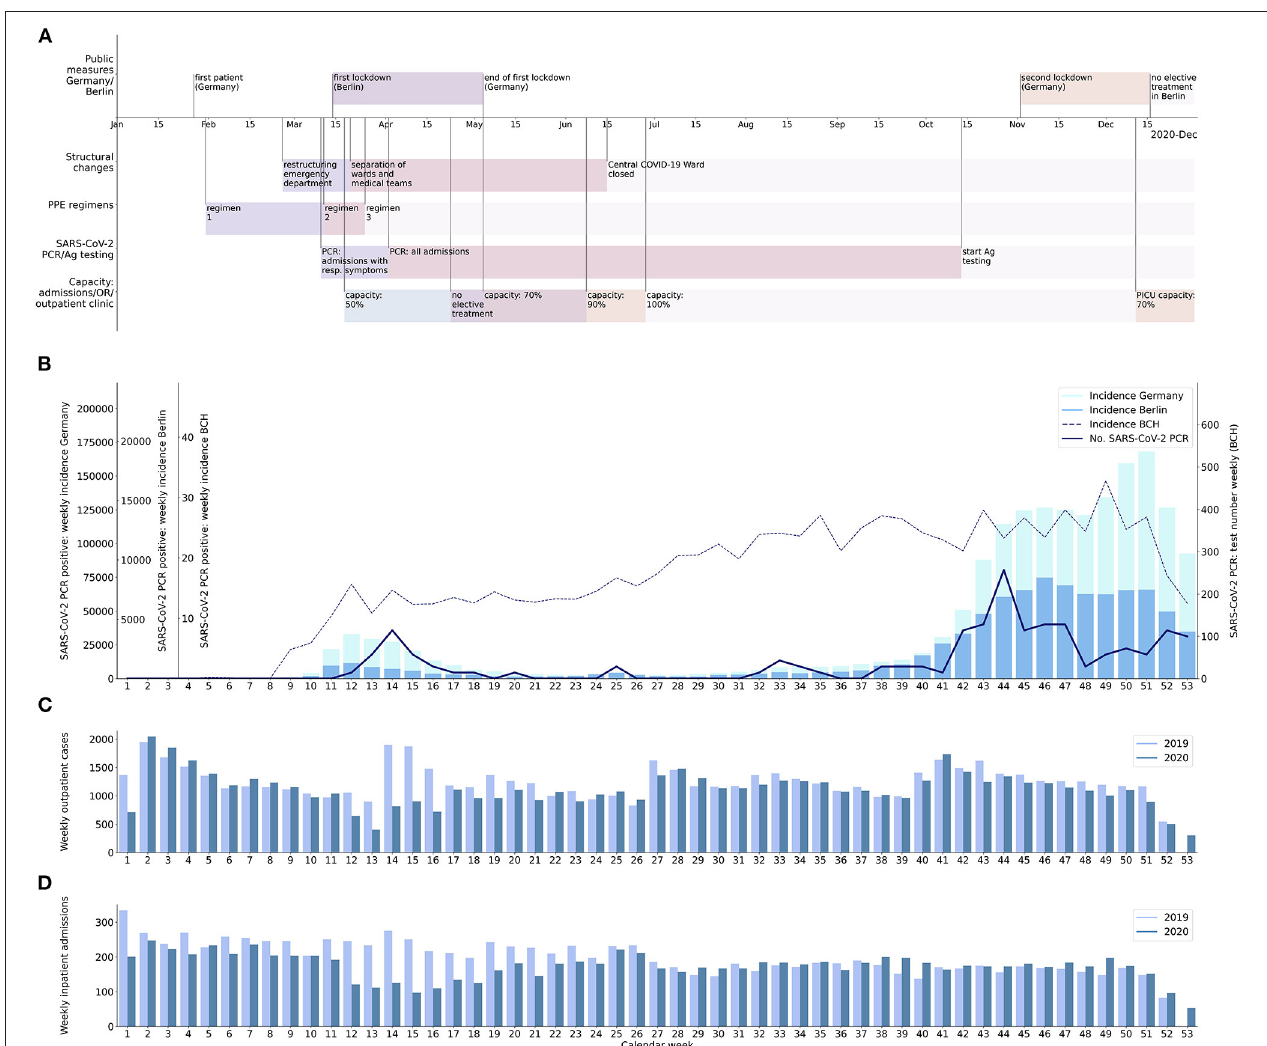
FIGURE 1 | Procedural changes at BCH in relation to changes in incidence of SARS-CoV-2 infection and inpatient and outpatient case numbers. (A) Timeline with an overview on internal and external measures imposed as a response to the COVID-19 pandemic; first row: events and public measures in Germany or Berlin; second row: reorganization of wards and staff; third row: personal protective equipment (PPE) regimens (for description of regimens, see Table 1 ); fourth row: SARS-CoV-2 PCR and SARS-CoV-2 Ag testing strategies; fifth row: limitation of inpatient treatment, outpatient treatment and operation room (OR) capacities; PICU: pediatric intensive care unit. (B) Incidence of SARS-CoV-2 infection per calendar week in Germany (bright bars), Berlin (dark bars), and at BCH (thick line), and number of SARS-CoV-2 PCR tests undertaken on inpatients or patients to be admitted per calendar week (dashed line). (C) Number of outpatient cases at BCH per calendar week in 2019 (bright bars) and 2020 (dark bars). (D) Number of inpatient admissions at BCH per calendar week in 2019 (bright bars) and 2020 (dark bars); there were only 52 calendar weeks in 2019, whereas 53 calendar weeks in